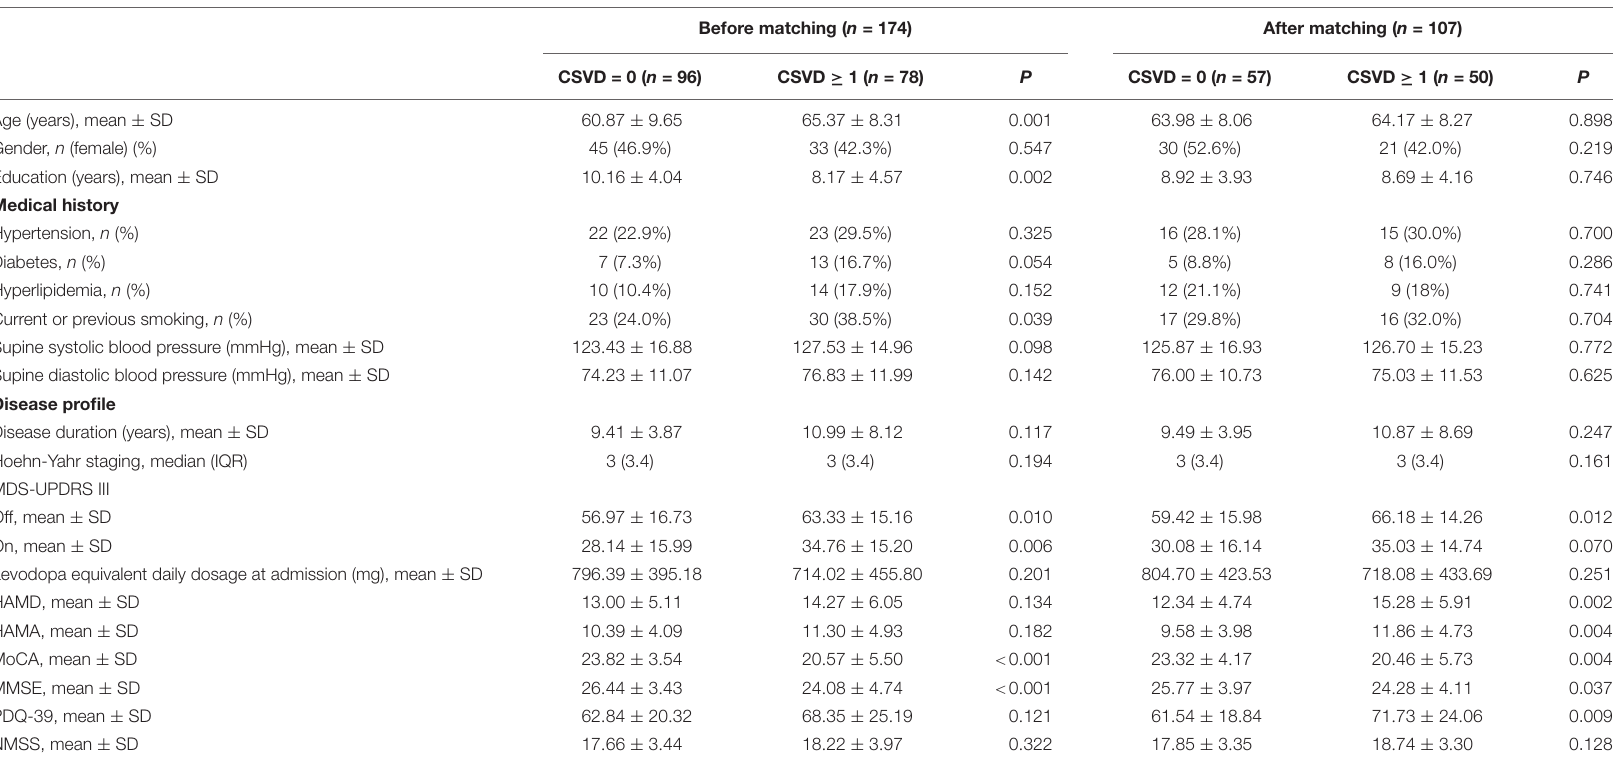
TABLE 3 | Clinical characteristics between CSVD = 0 and ≥ 1 before and after propensity score matching. Before matching ( n = 174) After matching ( n =